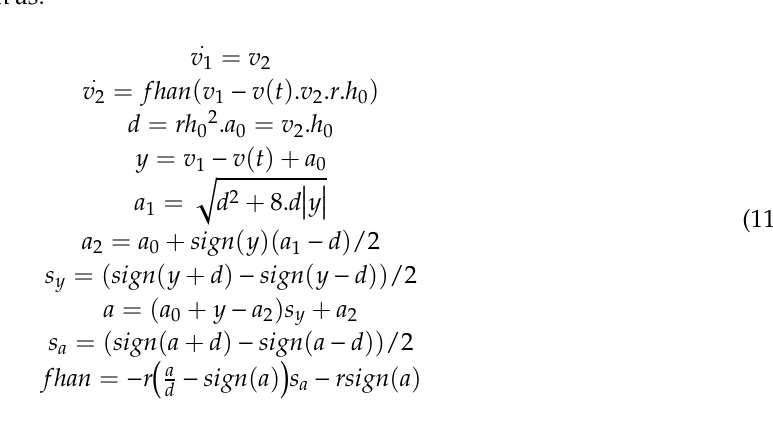
Figure 4. The block diagram of the active disturbance rejection controller (ADRC)